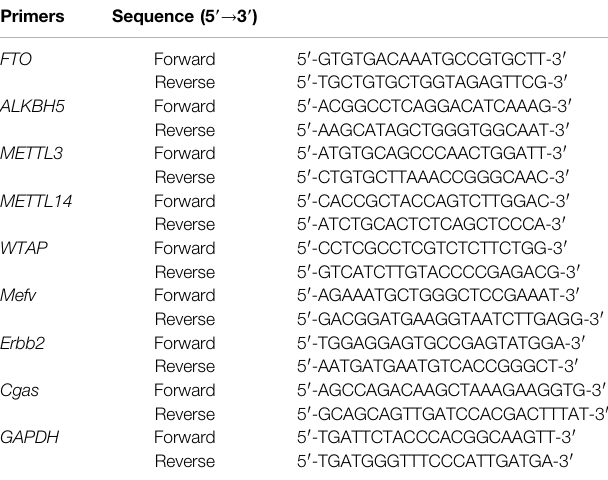
TABLE 1 | Primers used for real-time quantitative polymerase chain